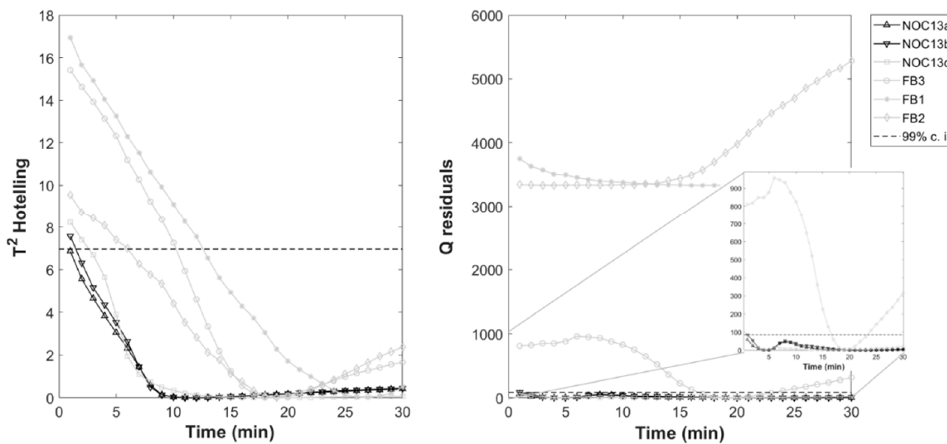
Figure 6. Multivariate Statistical Process Control (MSPC) charts for the three replicates of the milk renneting batch NOC 13 (in-control) and for the three failure batches FB (o ff -control): ( a ) Hotelling’s T 2 ; renneting batch NOC 13 (in-control) and for the three failure batches FB (off-control): a ) Hotelling’s T 2 ; ( b ) Q-statistic. Dashed line represents the 99% confidence interval b ) Q-statistic. Dashed line represents the 99% confidence interval (c.i.).